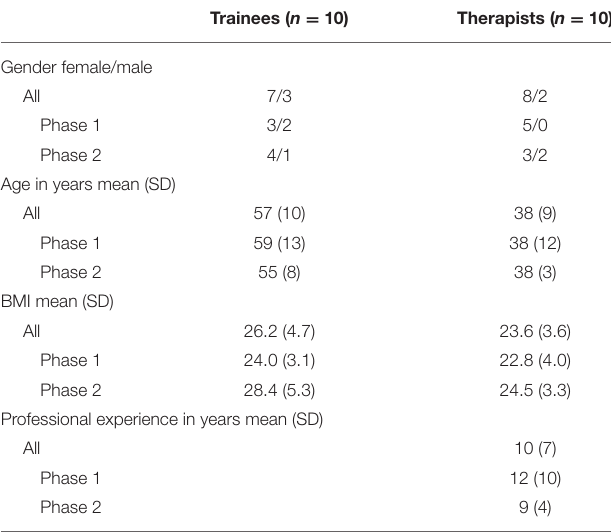
TABLE 3 | Outcome measurements usability. Outcome